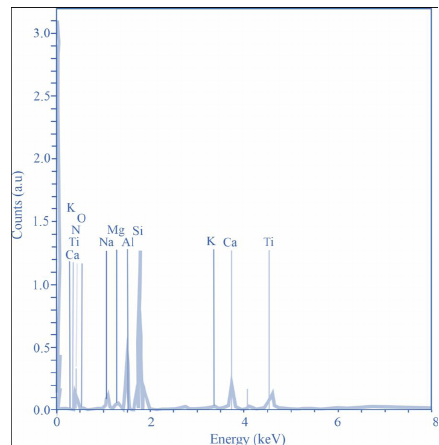
Figure 2. EDX spectrum of (Al,Ti,Si)N films deposited on glass